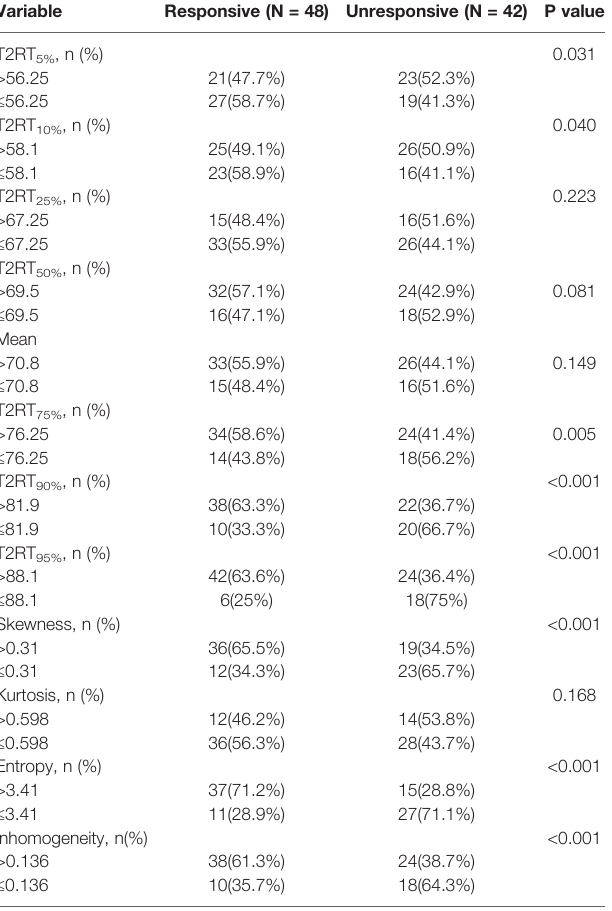
TABLE 3 | Univariate analysis of the histogram parameters on the response rate of ivMP. Variable